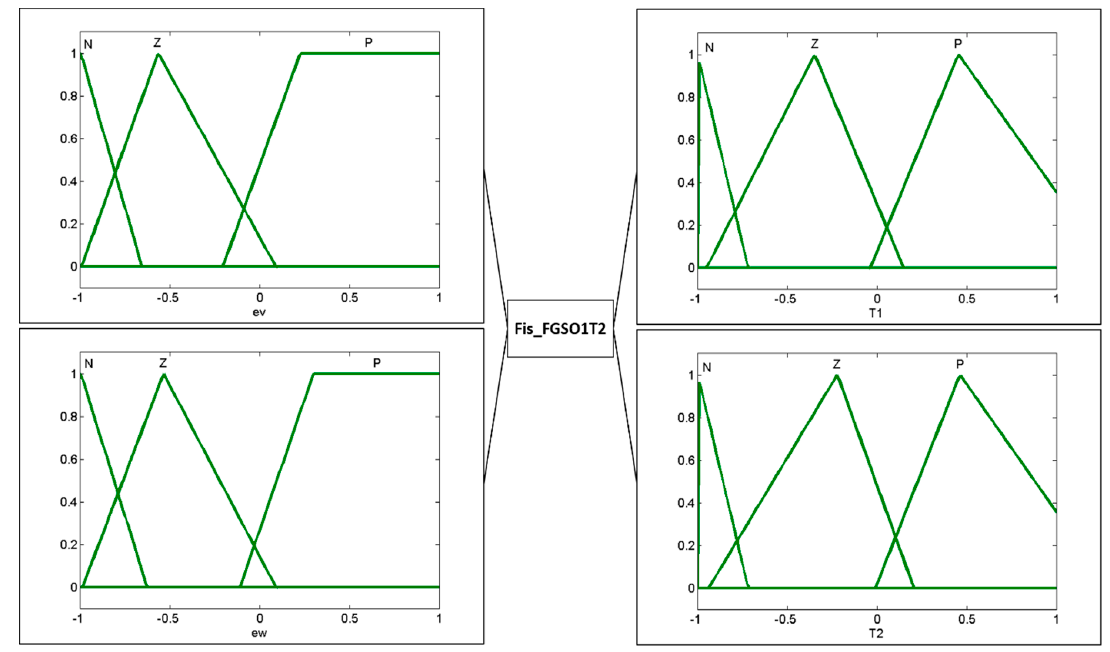
Figure 19. Fuzzy controller optimized with FGSO1T2.